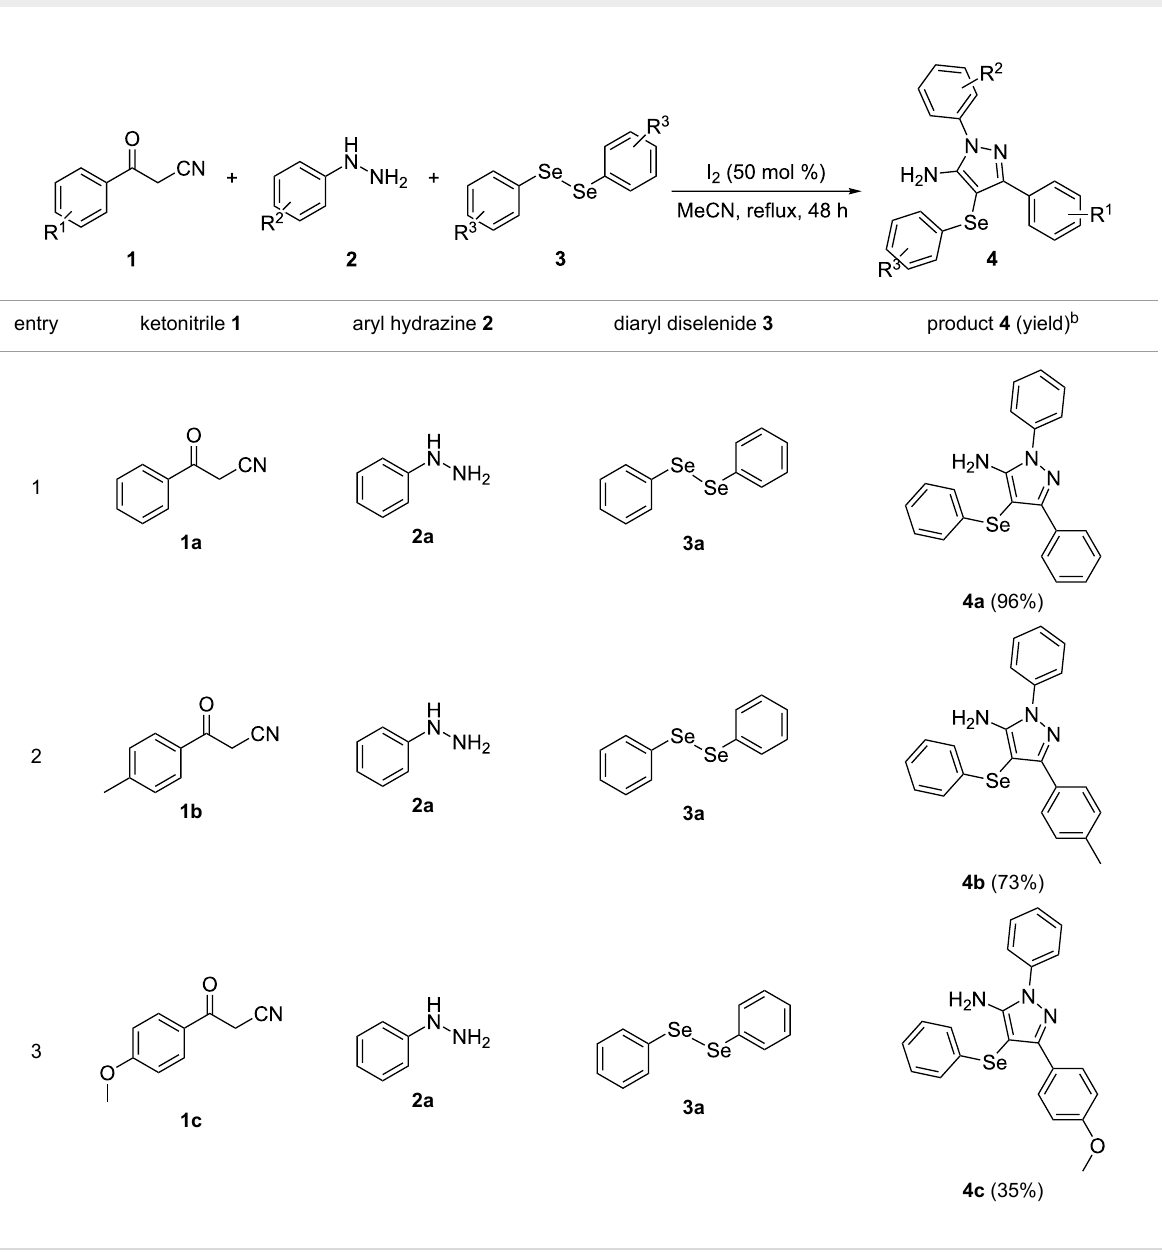
Table 2: Substrate scope for the synthesis of 5-amino-4-(arylselanyl)-1 H -pyrazoles 4 . a